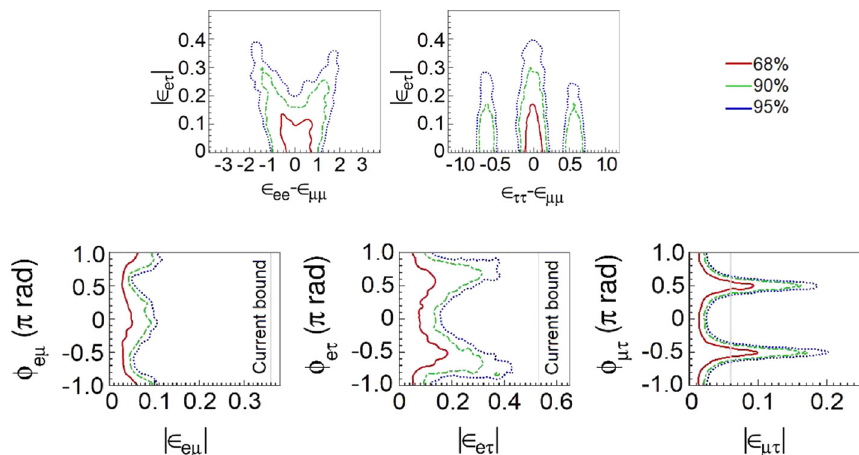
Fig. 7 Allowed regions of the non-standard oscillation parameters in which we see important degeneracies (top) and the complex non-diagonal ones (bottom). We conduct the analysis considering all the NSI parameters as non-negligible. The sensitivity regions are for 68% CL [red line (left)], 90% CL [green dashed line (middle)], and 95% CL [blue dotted line (right)]. Current bounds are taken from